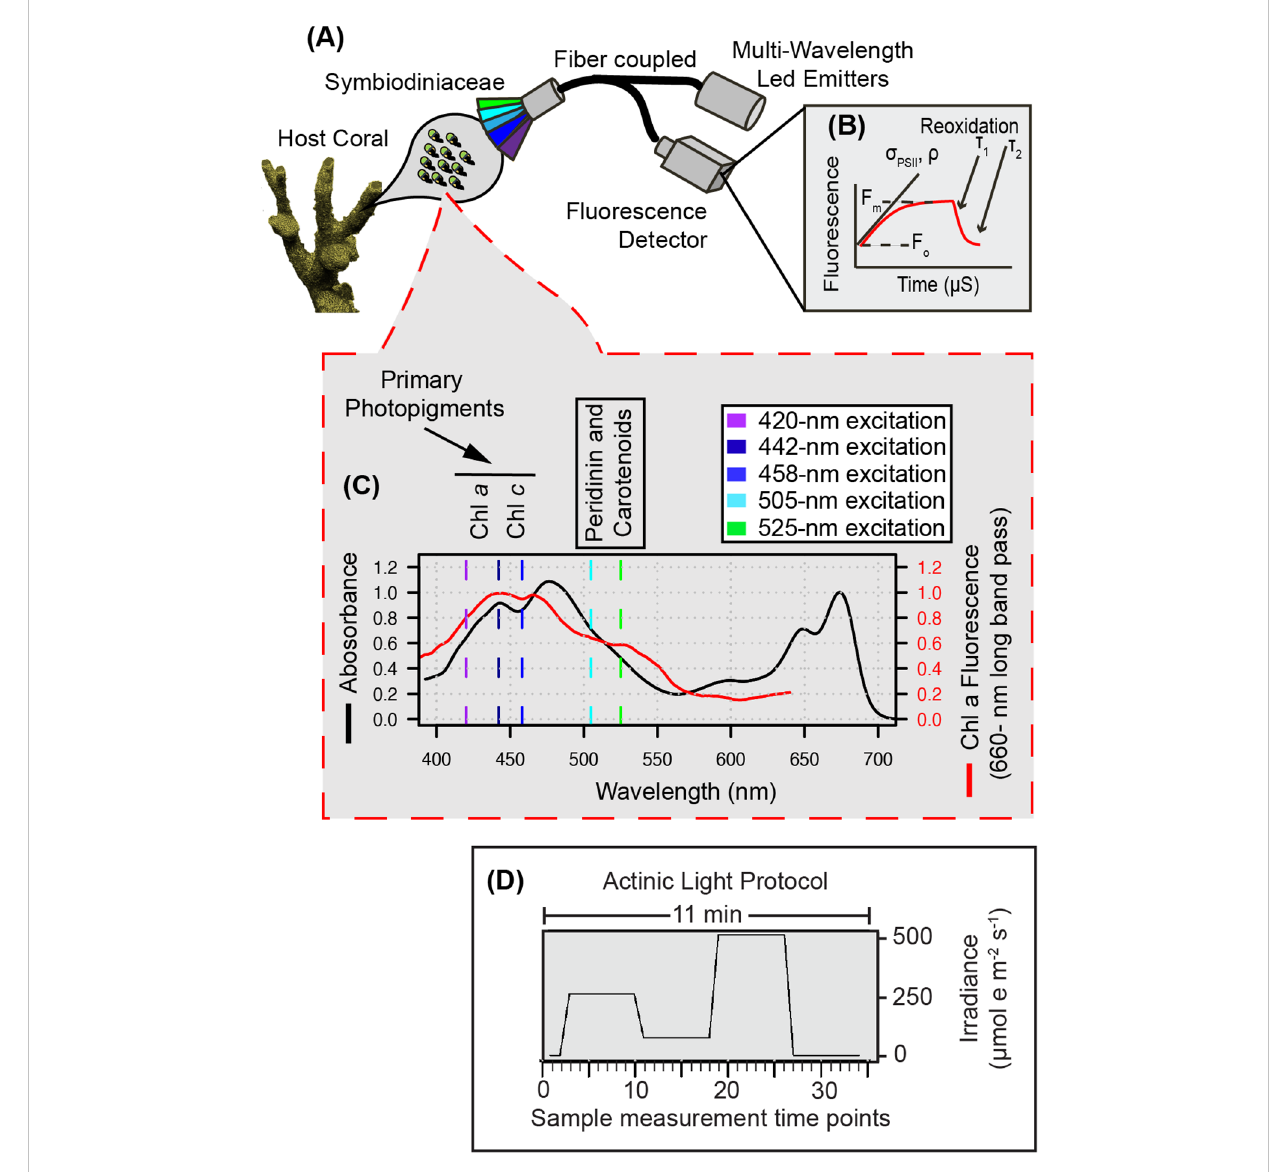
FIGURE 1 Multispectral conceptual illustration. Drawing of coral and symbiotic algae (A) illustrates the capture of a fl uorescent signature where speci fi c photopigments are preferentially excited by multispectral LEDs to resolve a µs fl uorescence signal (B) captured through our single turnover system. Light absorption (black line) and fl uorescence emission (red line) spectra from a representative algal culture (C) re fl ect differences in photopigment energy transfer that can be captured through multispectral excitation. Our benchtop fi ber optic-based instrument exposes coral samples to an 11- minute protocol (D) during which multiple sampling events are carried out and enable the capture of spectrally dependent photosynthetic signatures in response to acclimation to three different irradiance levels and dark